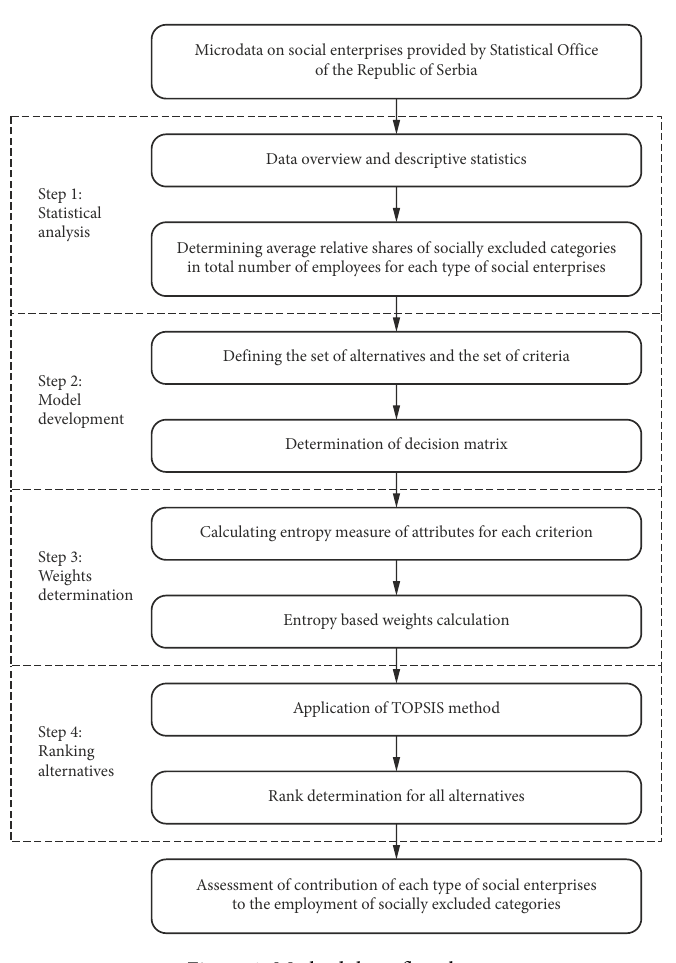
Figure 1. Methodology